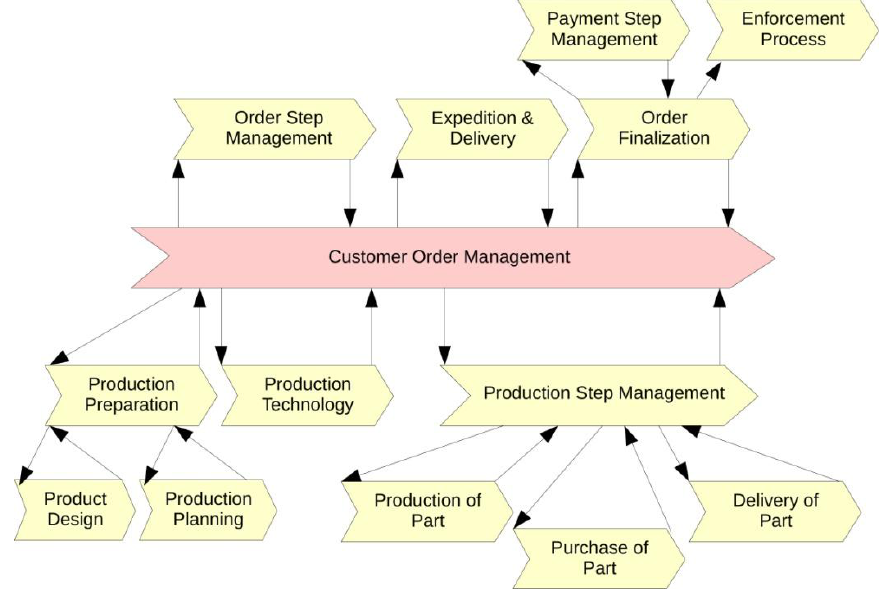
Figure 9. Final Process